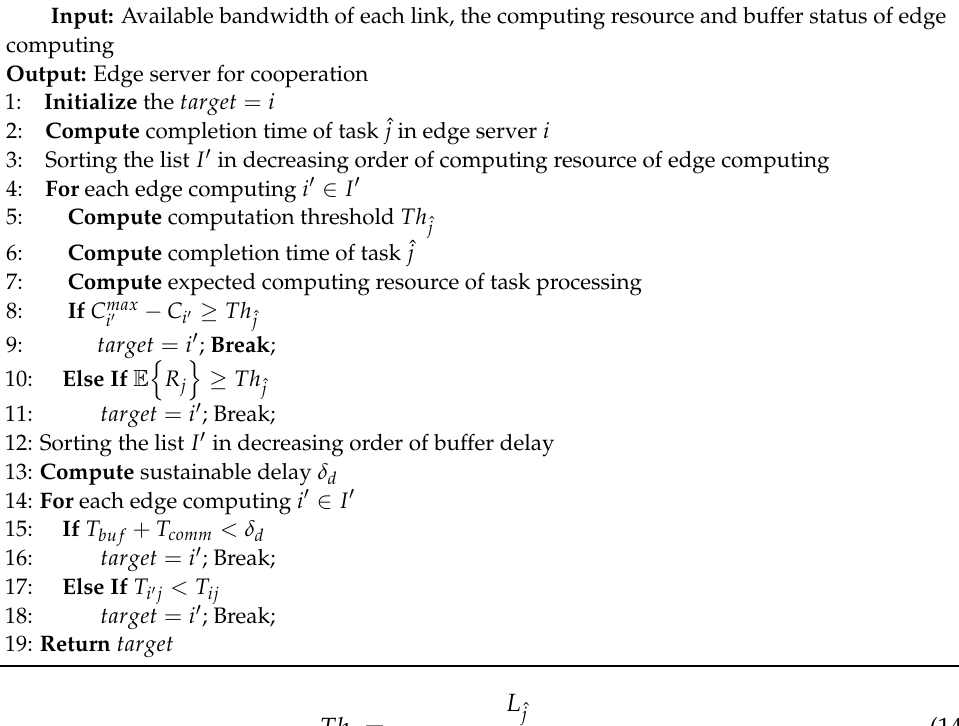
Algorithm 1 Greedy-based Edge